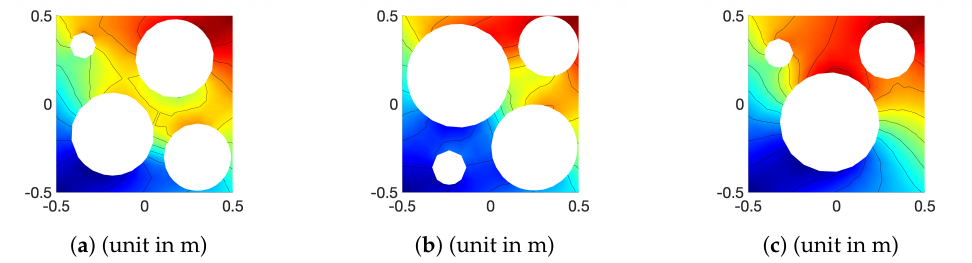
Figure 2. Three samples of randomly generated microstructures: The radii and the centers are selected randomly and are limited to prevent them from overlapping with other voids or not to intersect with the domain’s boundary. ( a ) Microstructure #15, ( b ) Microstructure #35, and ( c ) Microstructure